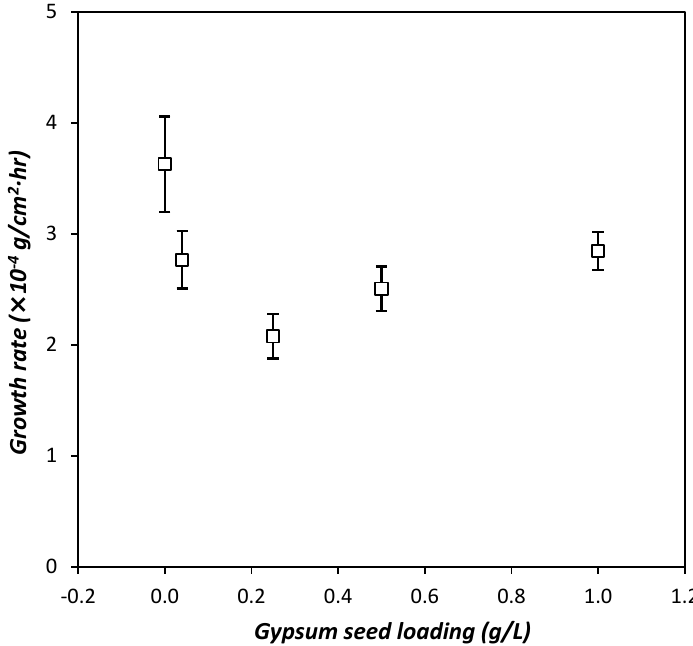
Figure 12. Normalized gypsum scale growth rate as a function of seed loading.